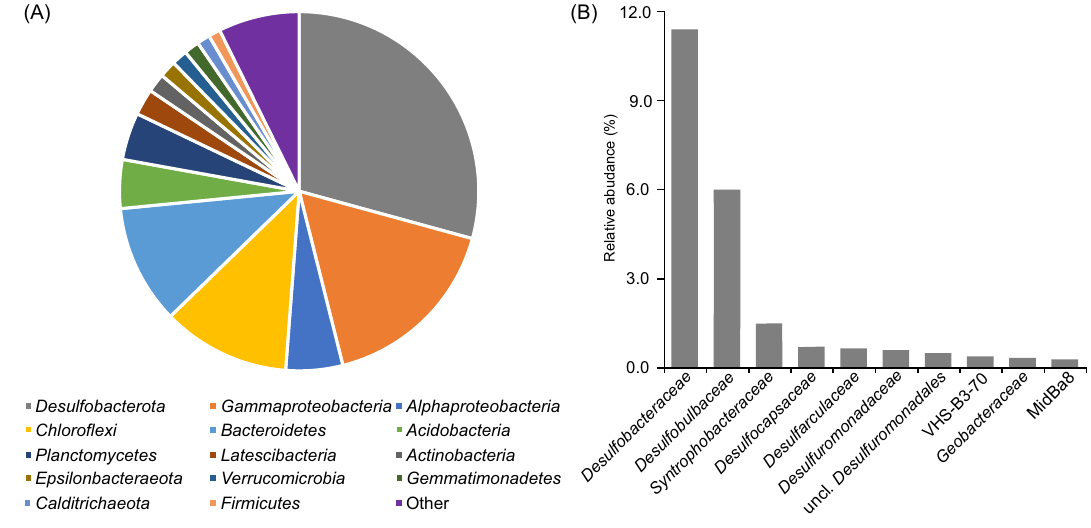
Figure 4. Relative abundance of bacterial taxa at the phylum/class level ( a ) and the 10 most abundant families from the phylum Desulfobacterota ( b